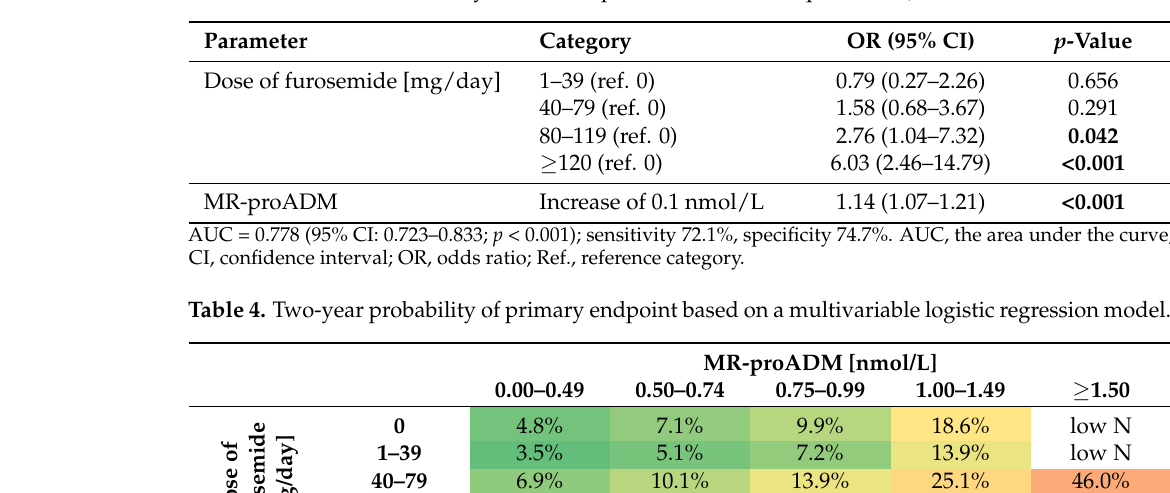
Table 3. Multivariable logistic regression model of the primary endpoint (i.e., the two-year prognosis in terms of all-cause mortality, heart transplantation, LVAD implantation).